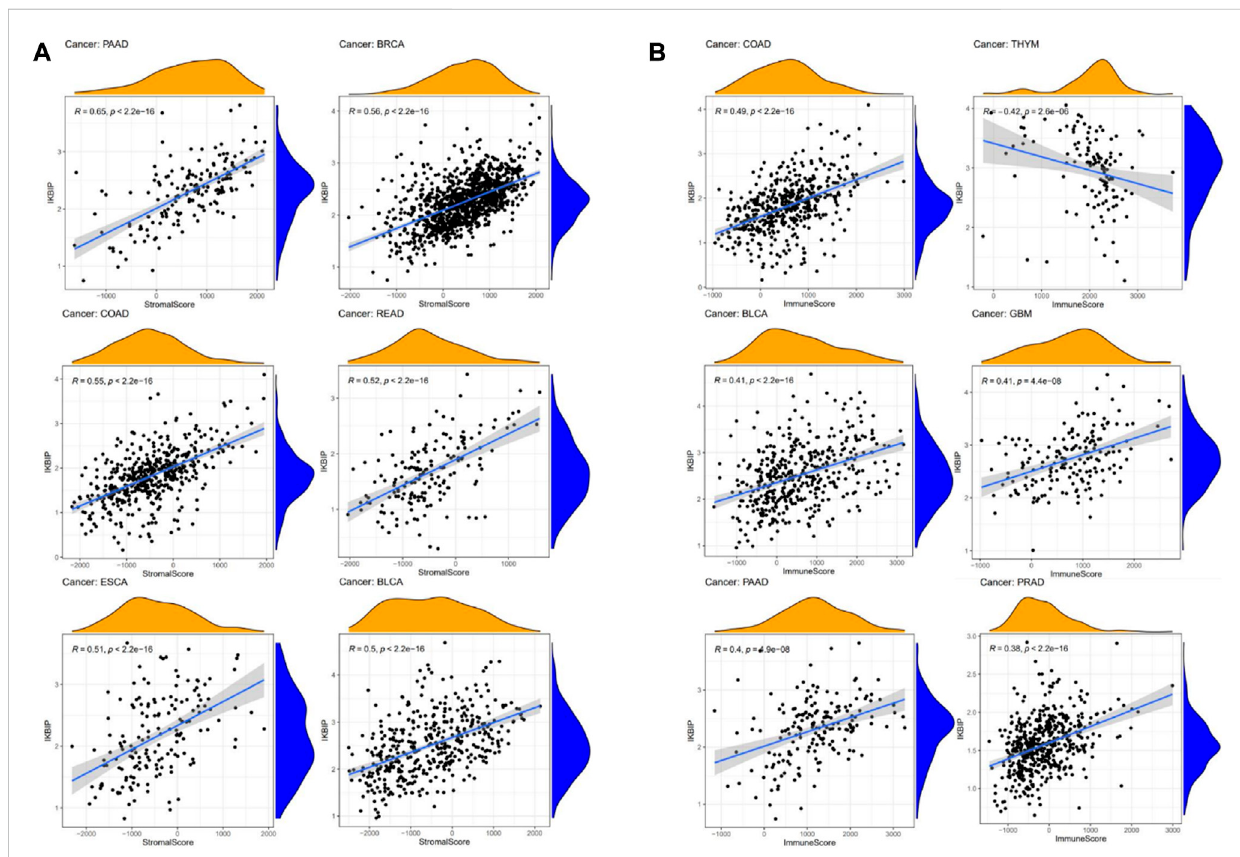
FIGURE 7 Six cancers with the highest association coef fi cients between IKBIP expression and the TME. (A) IKBIP expression was positively associated with stromal scores in pancreatic cancer (PAAD), breast cancer (BRCA), colon cancer (COAD), rectal cancer (READ), esophageal cancer (ECSA) and bladder urothelial carcinoma (BLCA). (B) IKBIP expression was negatively correlated with immune scores in thymic carcinoma (THYM) and positively correlated withimmunescores inthyroidcancer coloncancer(COAD),kidneyclearcell carcinoma (BLCA),glioblastomamultiforme(GBM), pancreaticcancer (PAAD), and prostatic cancer